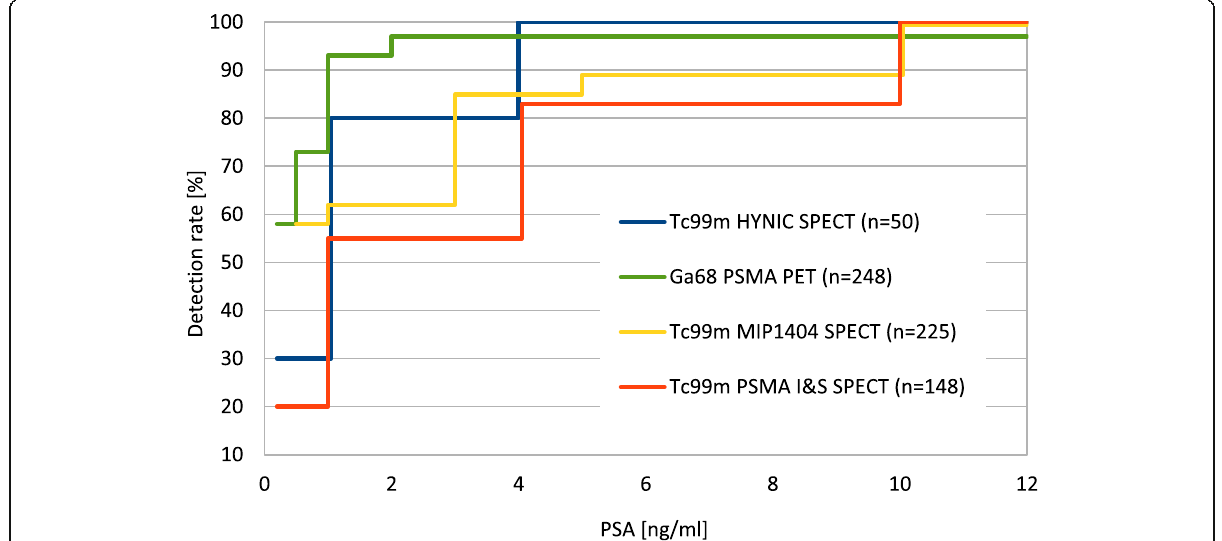
Fig. 8 Detection rates of different PSMA ligands in recurrent PCa. The figure was adapted from PSMA imaging detection rates from Su H-C. et al. [6] (Blue), Eiber M. et al. [10] (green), Schmidkonz C. et al. [4] (yellow), and the present study